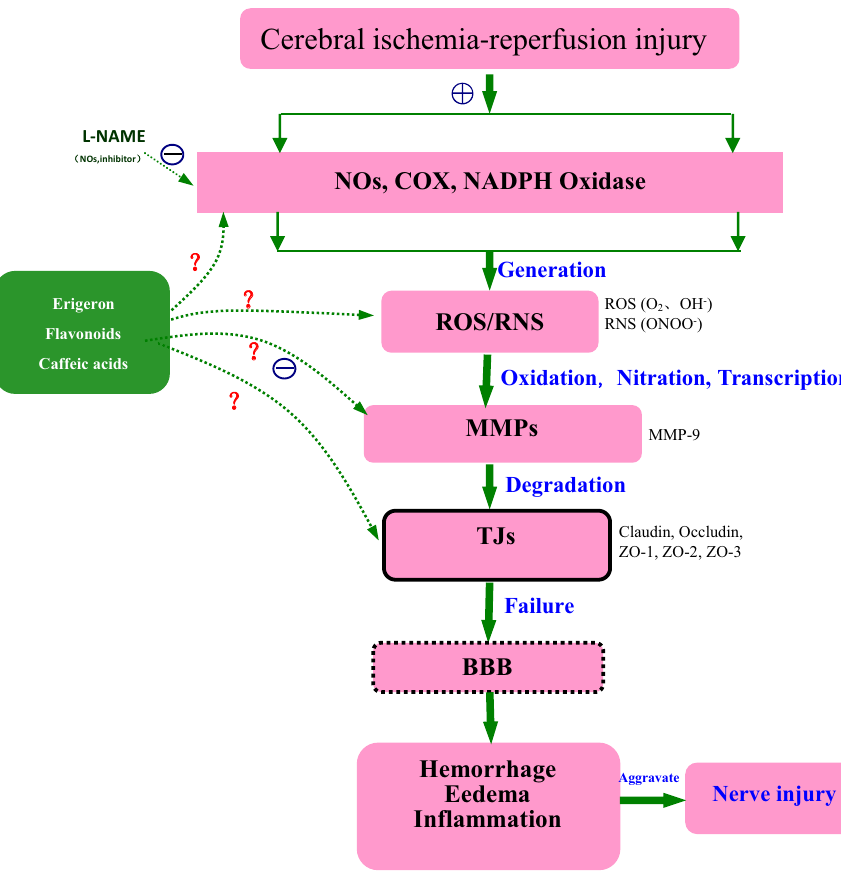
Figure 1. Schematic diagram of ROS/RNS-MMPs-TJs involved in cerebral ischemic BBB